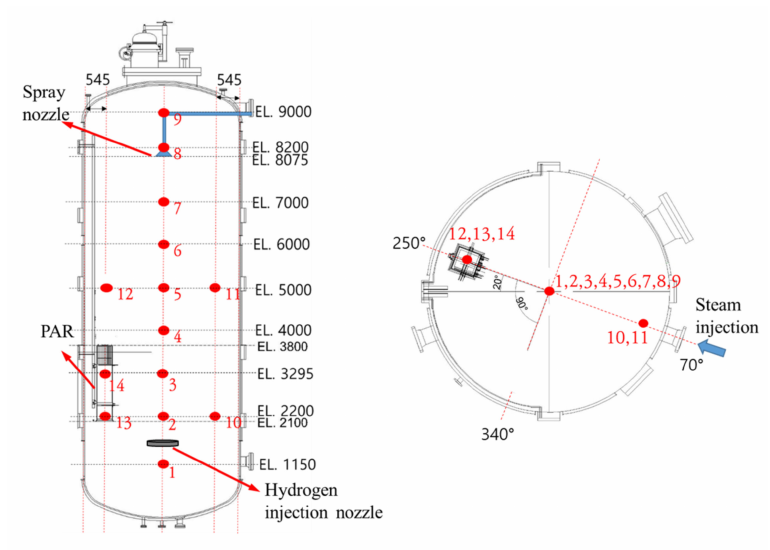
Figure 2. Measurement points of hydrogen and oxygen concentrations, vapor humidity, and temper- ature for SPARC